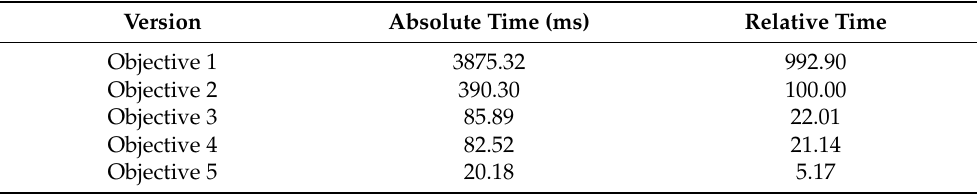
Table 1. Timing results for the five objective functions. The second column contains the average computation time (over 100 replications) in milliseconds. The third column shows percentages, where the second objective function serves as the